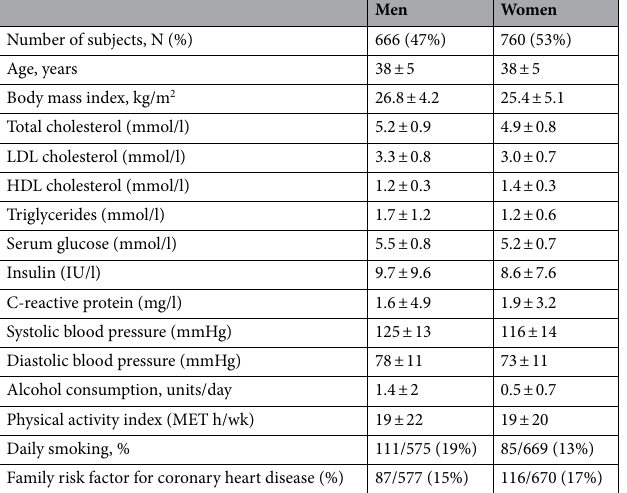
Table 1. Population characteristics of the Cardiovascular Risk in Young Finns Study cohort. Data are expressed as mean ± SD or percentages.